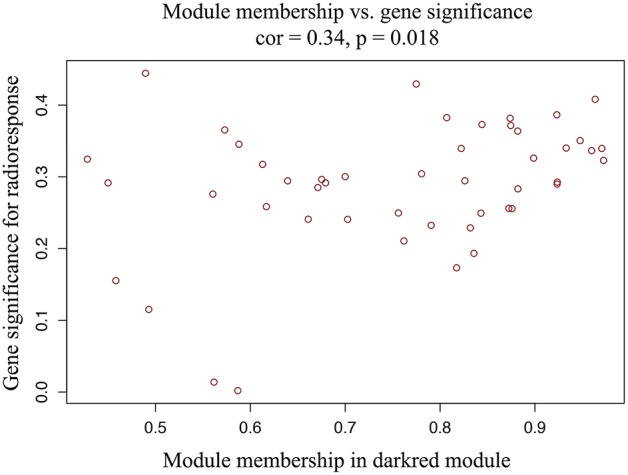
The scatter plot shows the correlation between gene significance for radioresponse and module membership in darkred module (Cor = 0.34, P = 0.018).